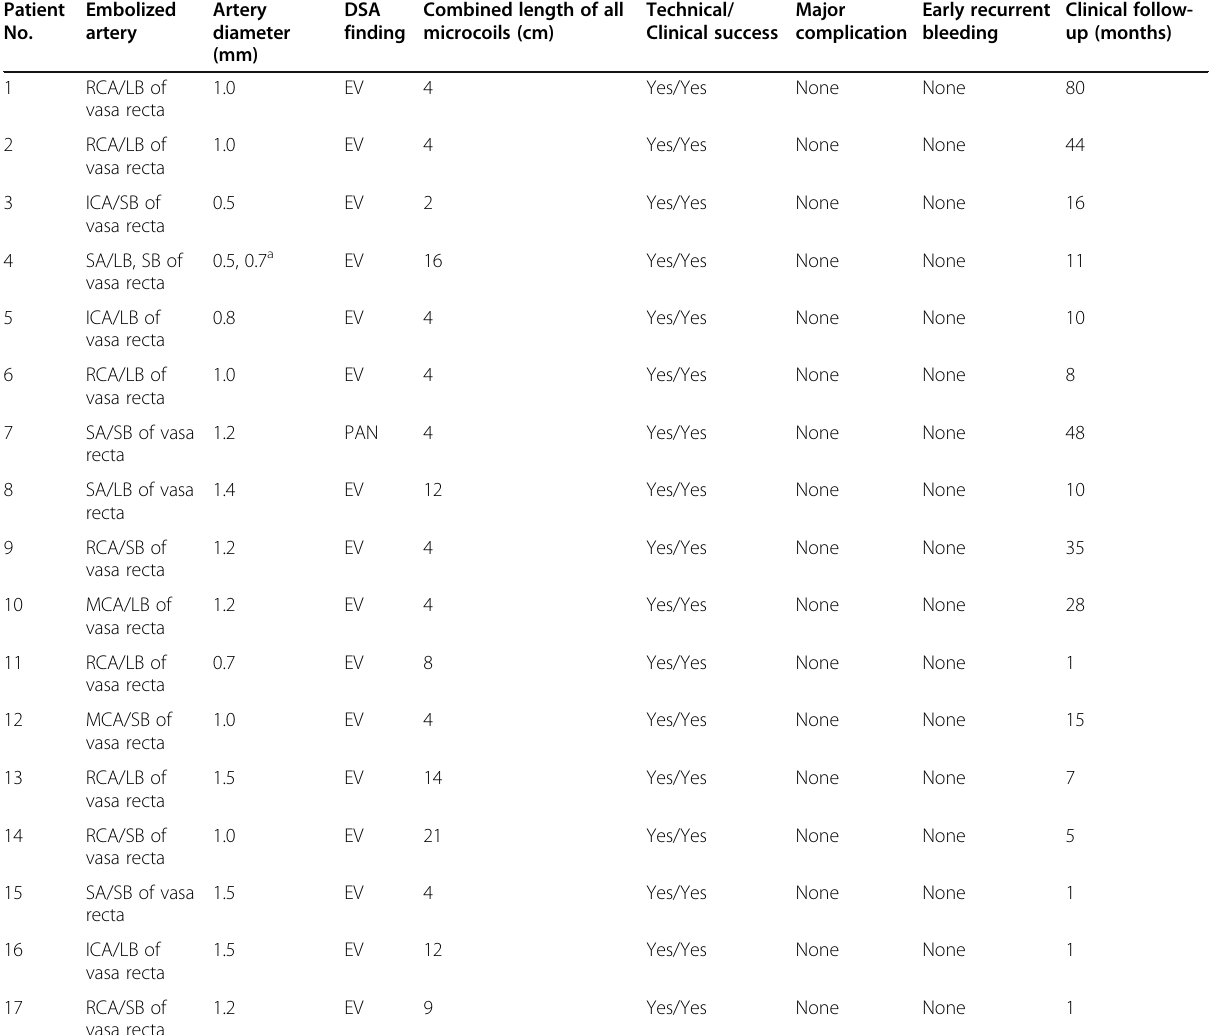
Table 2 The summary of transcatheter arterial embolization outcomes Patient